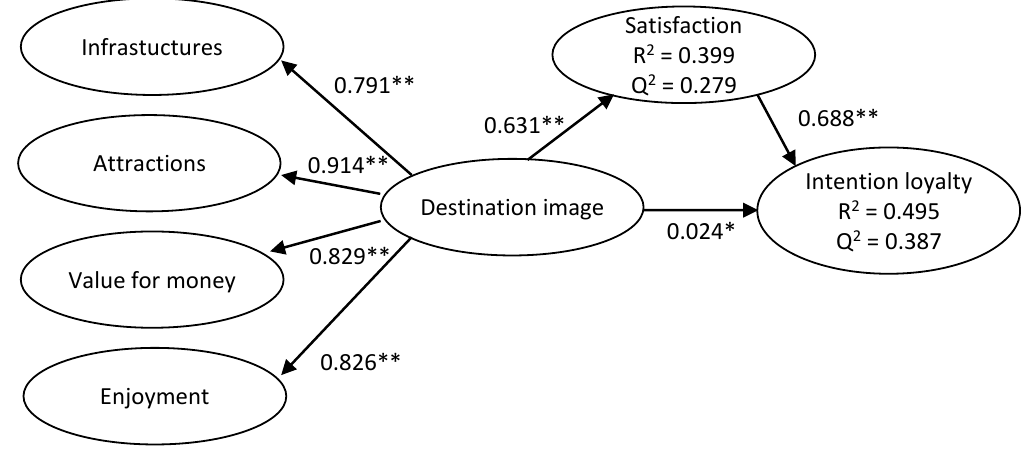
Figure 2. Results of a structural